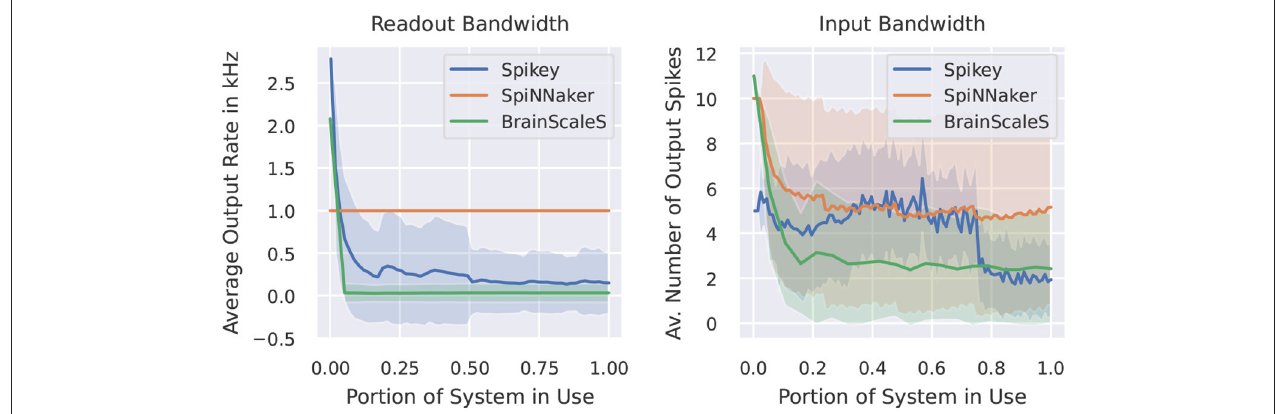
FIGURE 5 | Measured output rate (left) and the indirectly measured input rate from virtual spike source neurons using a one-to-one connection scheme (right). Light coloring indicates the empirical standard deviation across neurons.